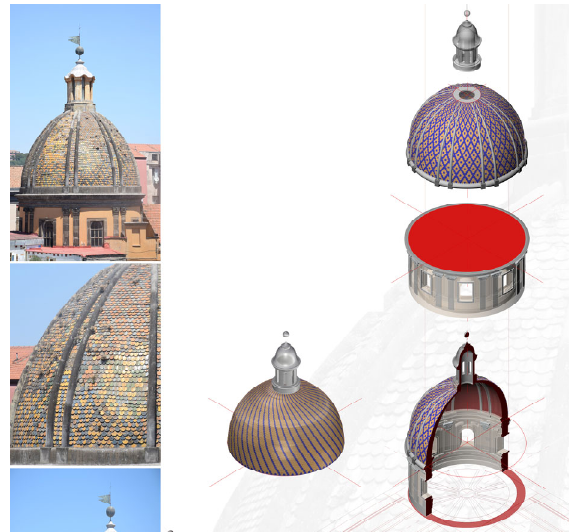
Figure 7. - Architectural Elements definition. Napoli, S. Maria Figure 8. Semantic classification, Architectural Elements definition. Napoli, S. Maria di Costantinopoli